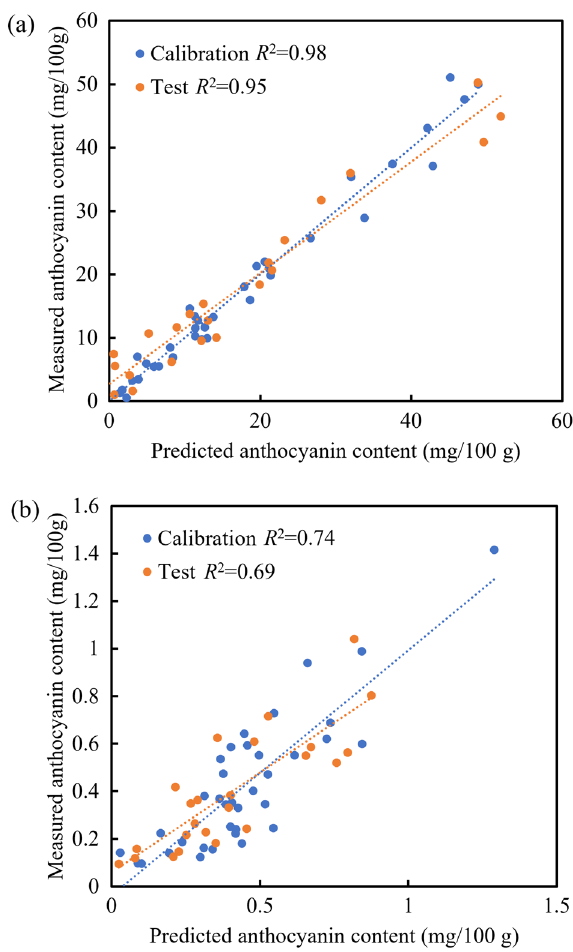
Figure 9. Predictive performance of the PLS models based on interactances obtained at the optimal SDS distances. The optimal PLS model for skin ( a ) was obtained at SDS distance number 1. The optimal PLS model for whole flesh ( b ) was obtained at SDS distance number